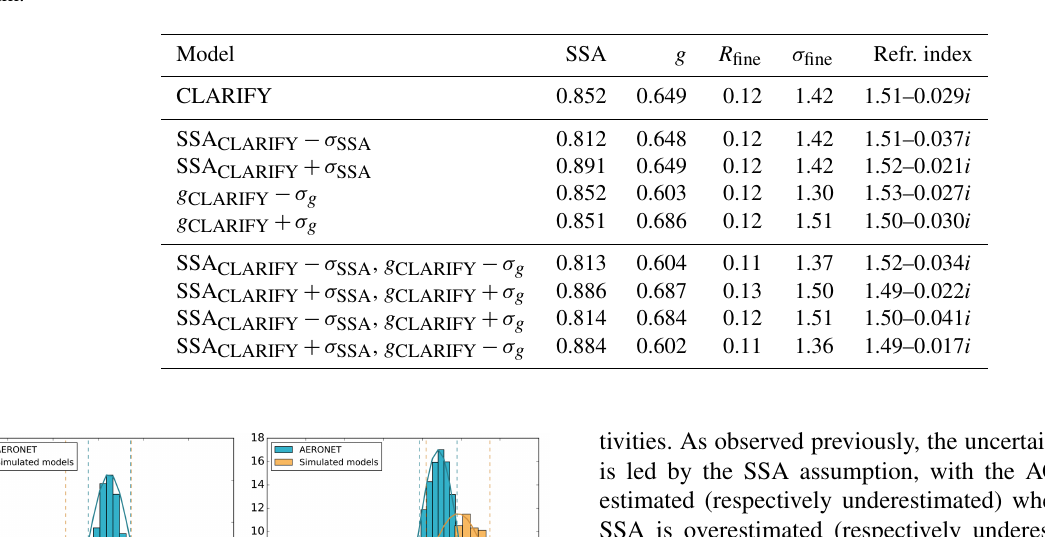
Figure 7. Uncertainty in the retrieved above-cloud AOT (a) , COT (b) and CER (c) due to an error of + 10% in orange and − 10% in blue on the specific humidity profile compared to the original forecast for 28 August 2017 at 10:12UTC. Table 2. Aerosol properties used to test the sensitivity of the SEVIRI retrieval to the aerosol model assumption. SSA and g are given at 0.55µm.